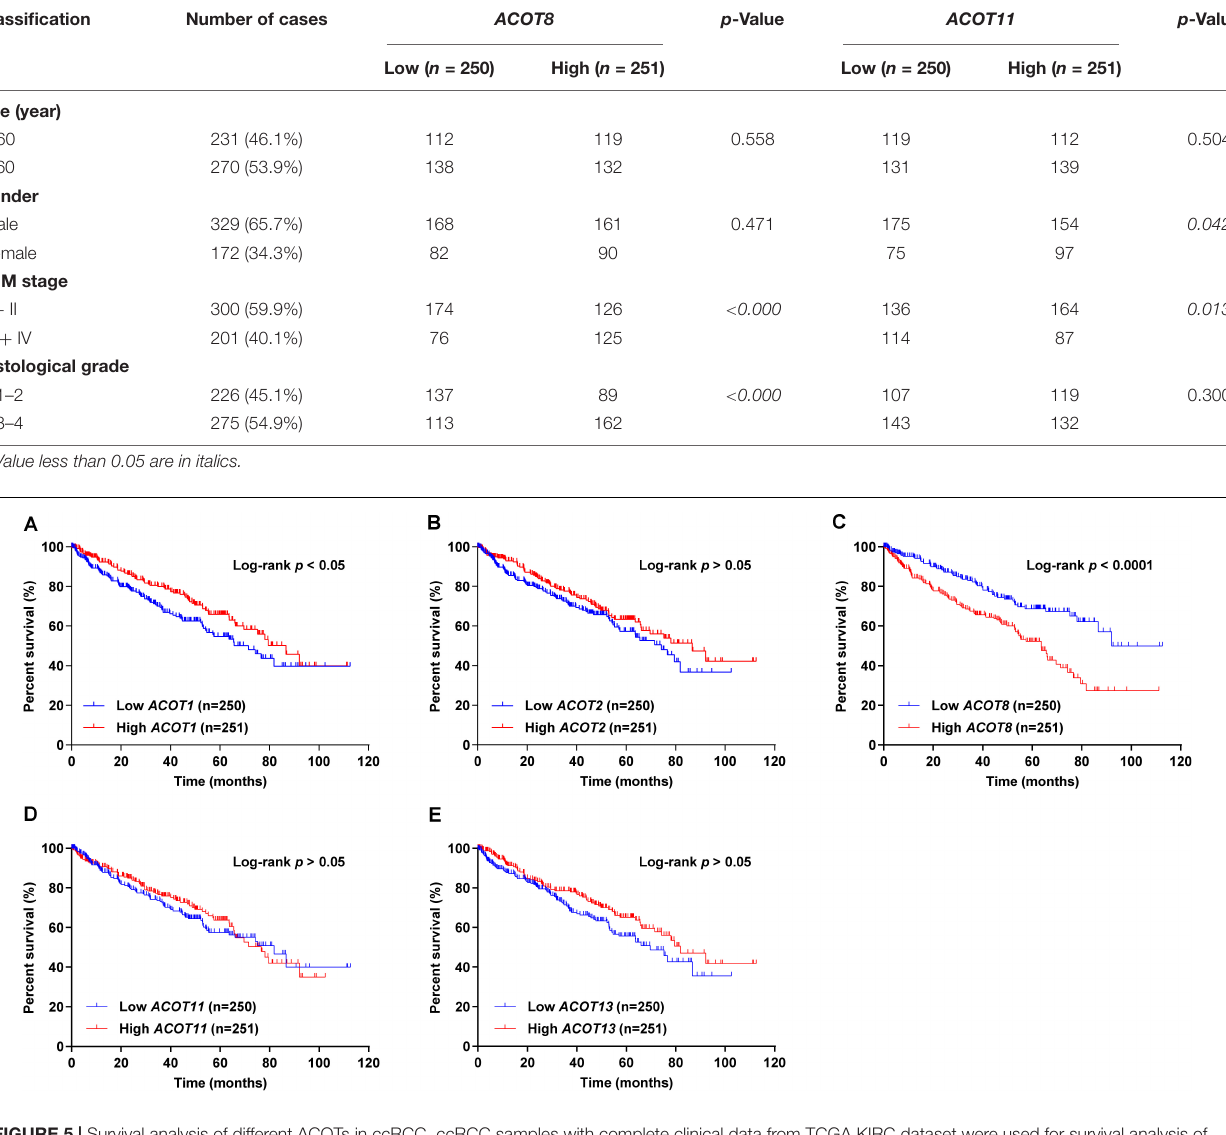
FIGURE 5 | Survival analysis of different ACOTs in ccRCC. ccRCC samples with complete clinical data from TCGA KIRC dataset were used for survival analysis of different ACOTs . ACOT1/8 expressions were significantly associated with the overall survival of ccRCC patients (A,C) , while the mRNA expressions of